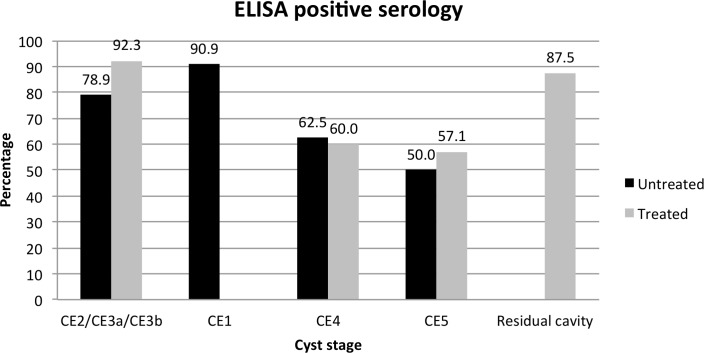
Percentage of untreated and previously treated CE patients with ELISA positive serology according to cyst stage.